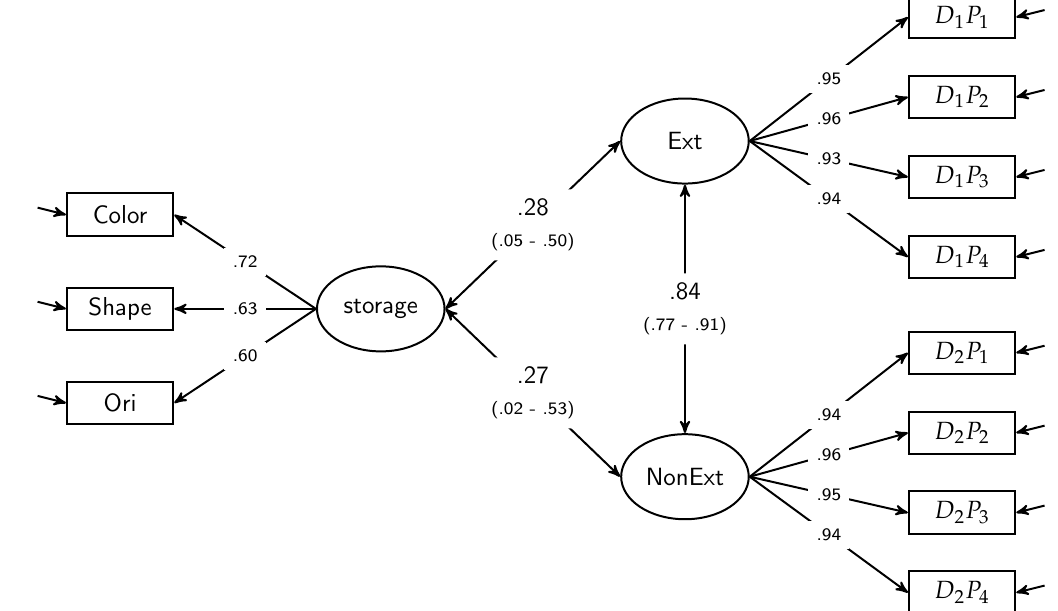
Figure 3. SEM for interrelations between storage capacity and the two versions of matrices tests applied in this study (Model 1). Parameters are standardized. CI of standardized estimates are in parentheses. Model fit : χ 2 (41) = 41.83, p = .43, CFI = .999, RMSEA = .016, SRMR = .043. Storage = storage